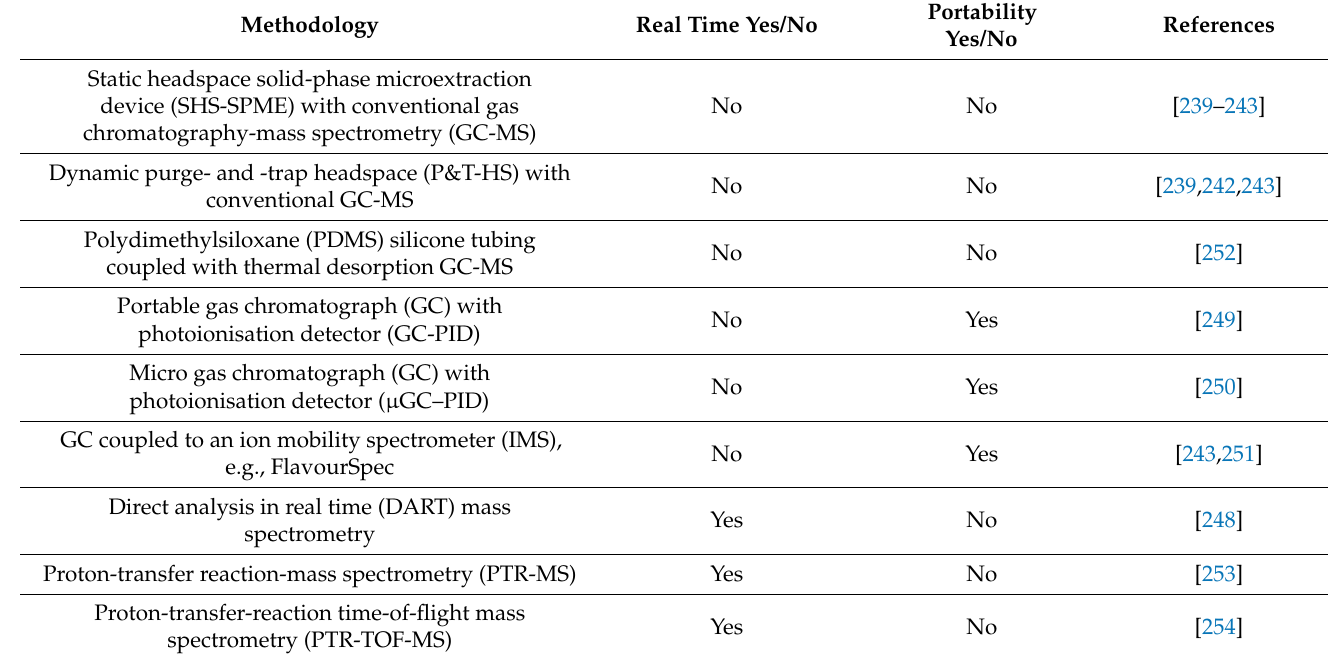
Table 2. Practical technologies used in plant volatile metabolite